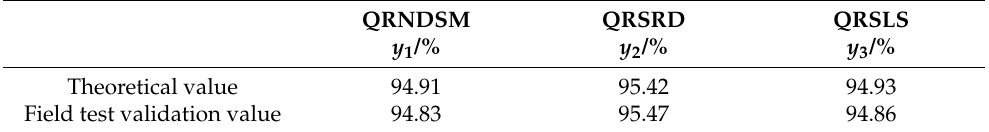
Table 8. Test results for the best